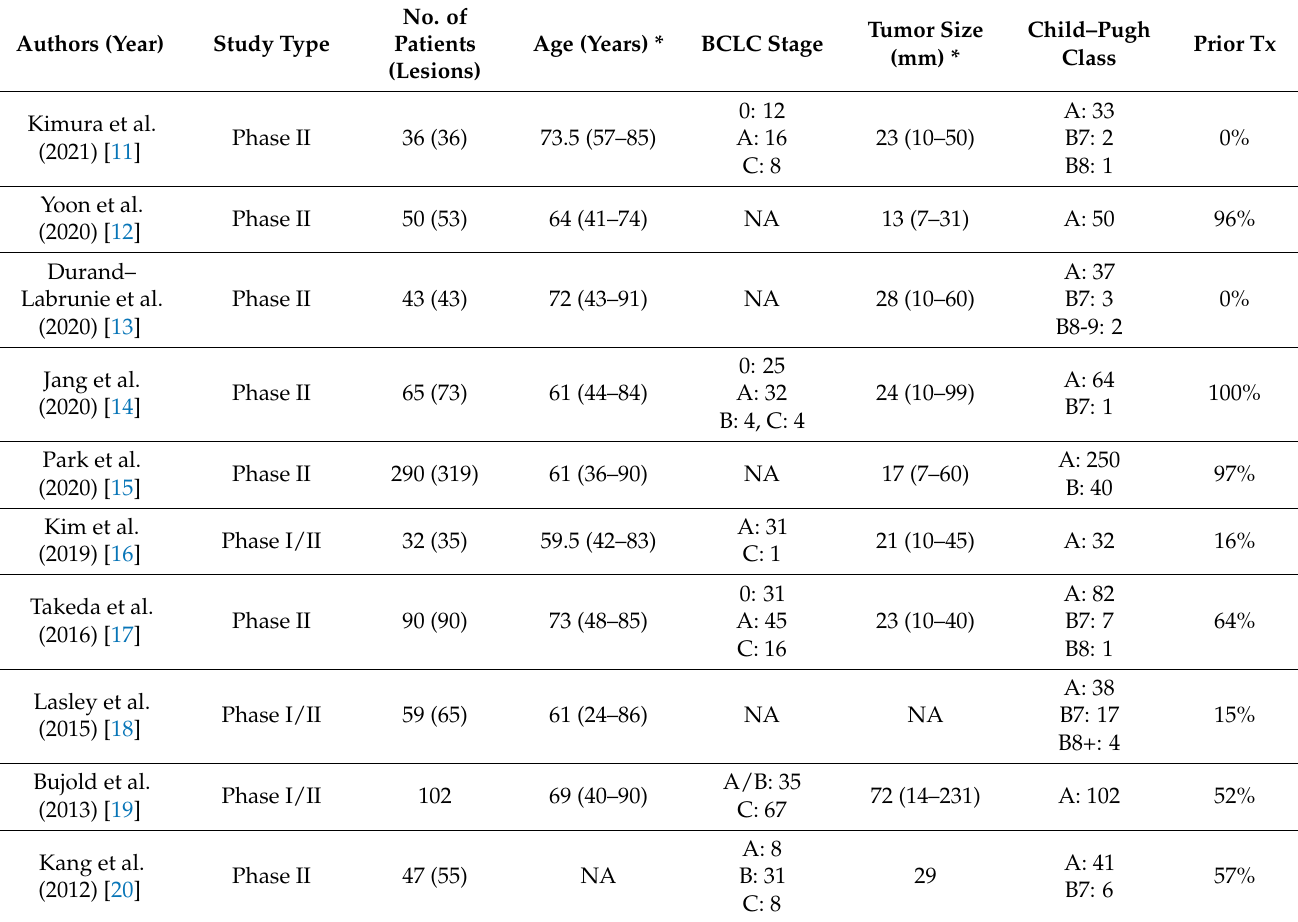
Table 1. Patient characteristics in selected studies of stereotactic body radiotherapy (SBRT) for hepatocellular carcinoma